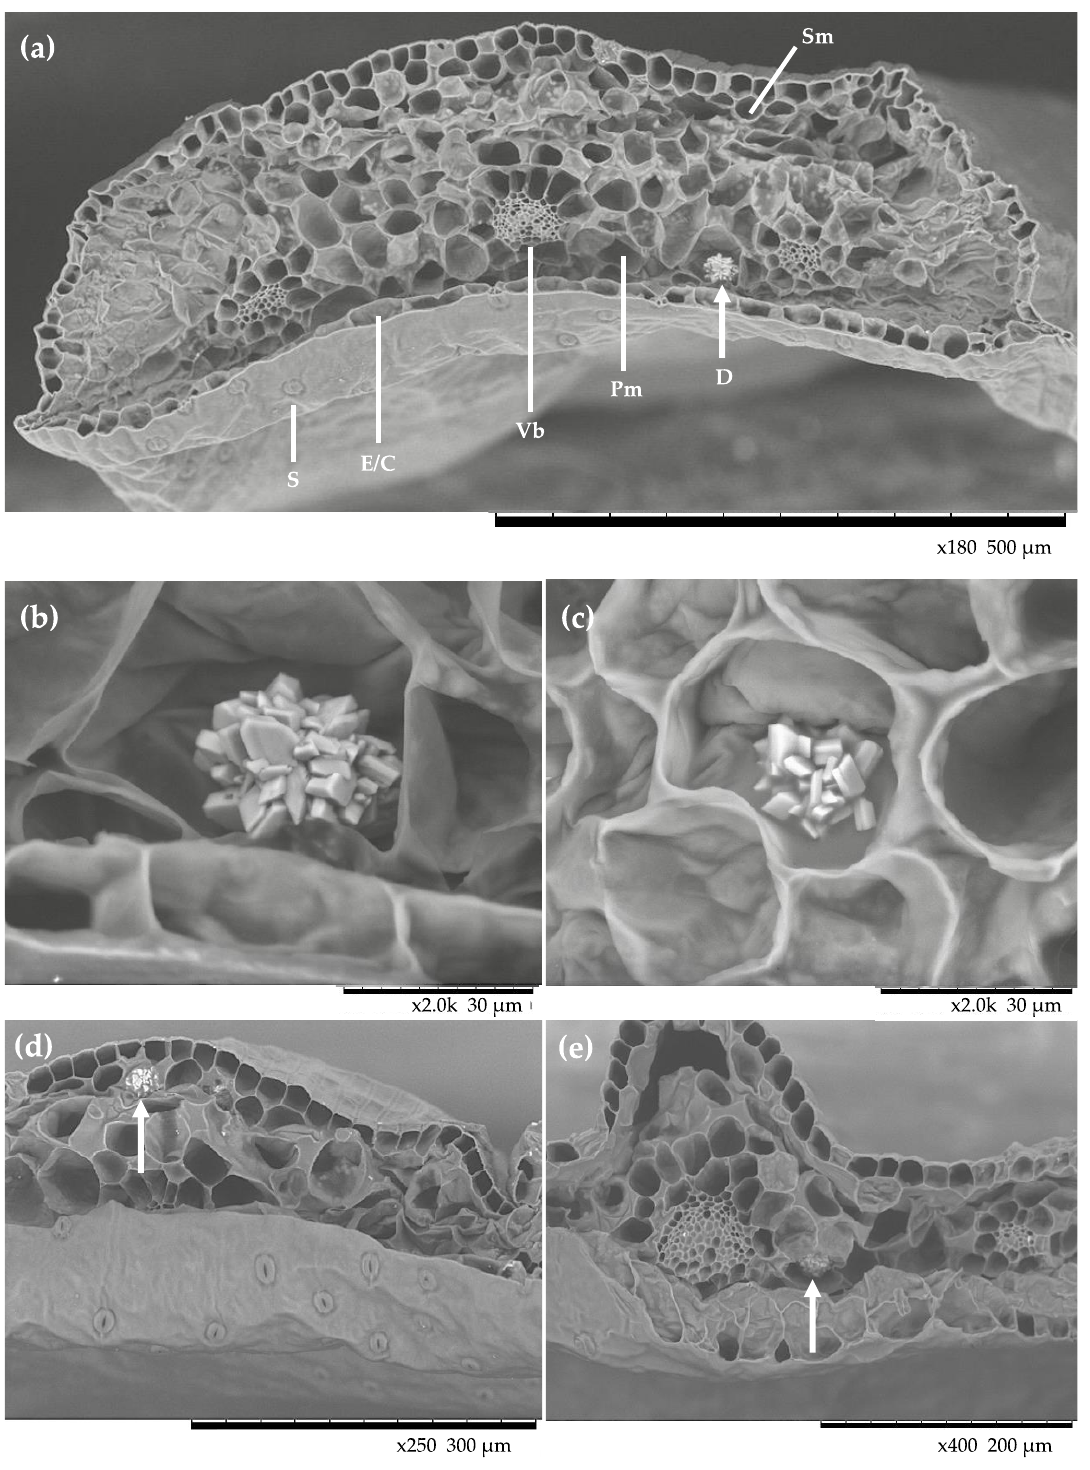
Figure 3. Scanning electron micrographs of calcium oxalate crystals in the leaf of Colobanthus quitensis Antarctic (Arctowski) ecotype. ( a ) Scanning electron micrograph showing a transverse section of C. quitensis leaf. A sizeable prickly crystal (white arrow) is located within mesophyll, near the vascular bundle.; ( b ) Amplification of the crystal observed in ( a ); ( c ) CaOx druse inside an idioblast.; ( d , e ) CaOx druses within mesophyll. In ( a ), Sm, Spongy mesophyll; S, Stoma; E, Epidermis; C, Cuticle; Vb, Vascular bundle; Pm, Palisade mesophyll; D, CaOx Druse.